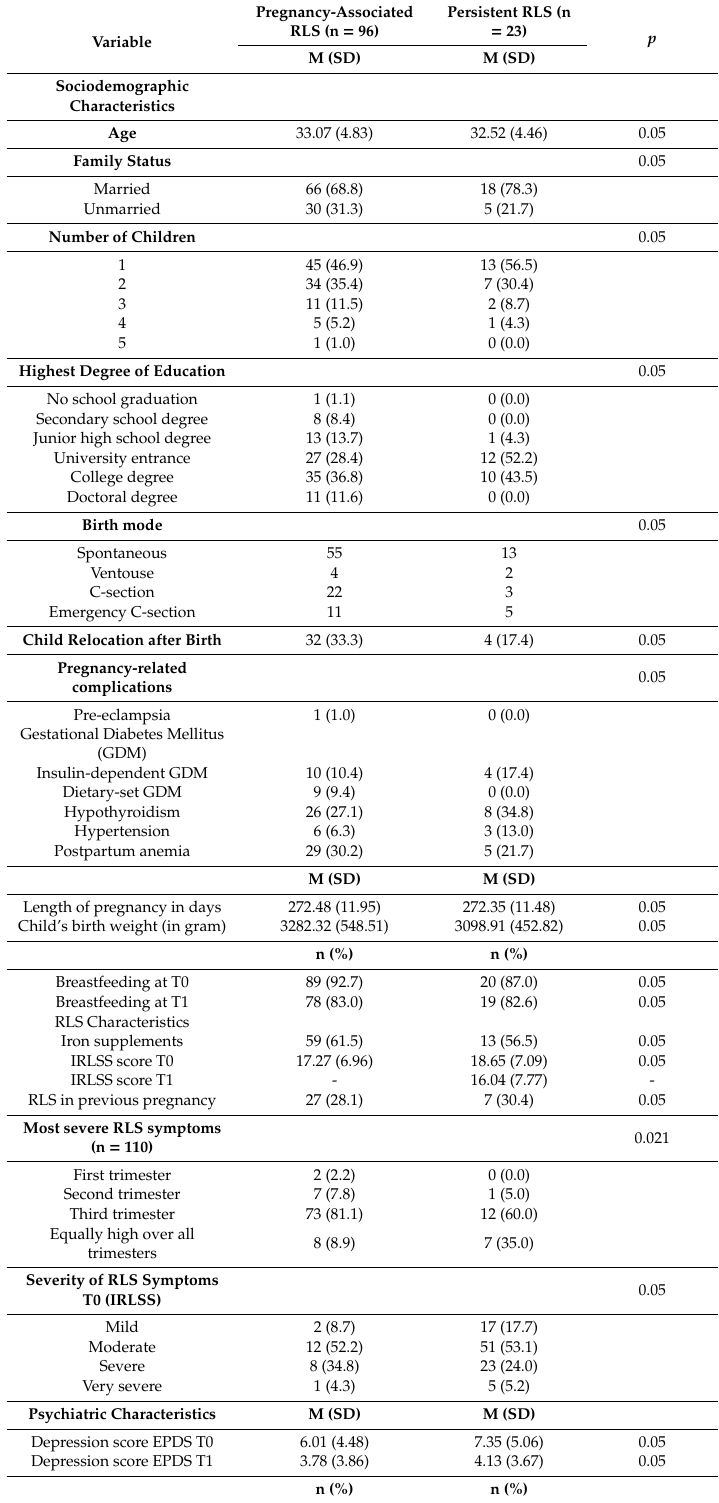
Table A4. Di ff erences between women with pregnancy-associated RLS and persistent